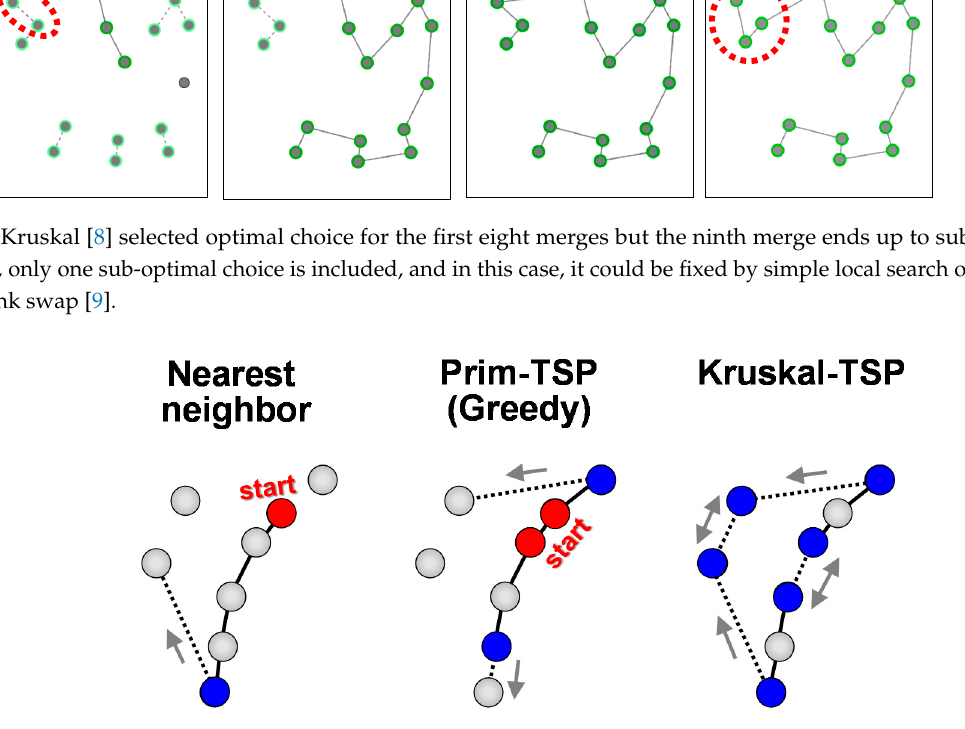
Figure 6. Christofides operates by adding links so that Euler tour can be achieved. However, the quality of the result depends on the order in which the links are travelled. In this case, it achieves optimal choice for closed loop solution but not for the open loop case.